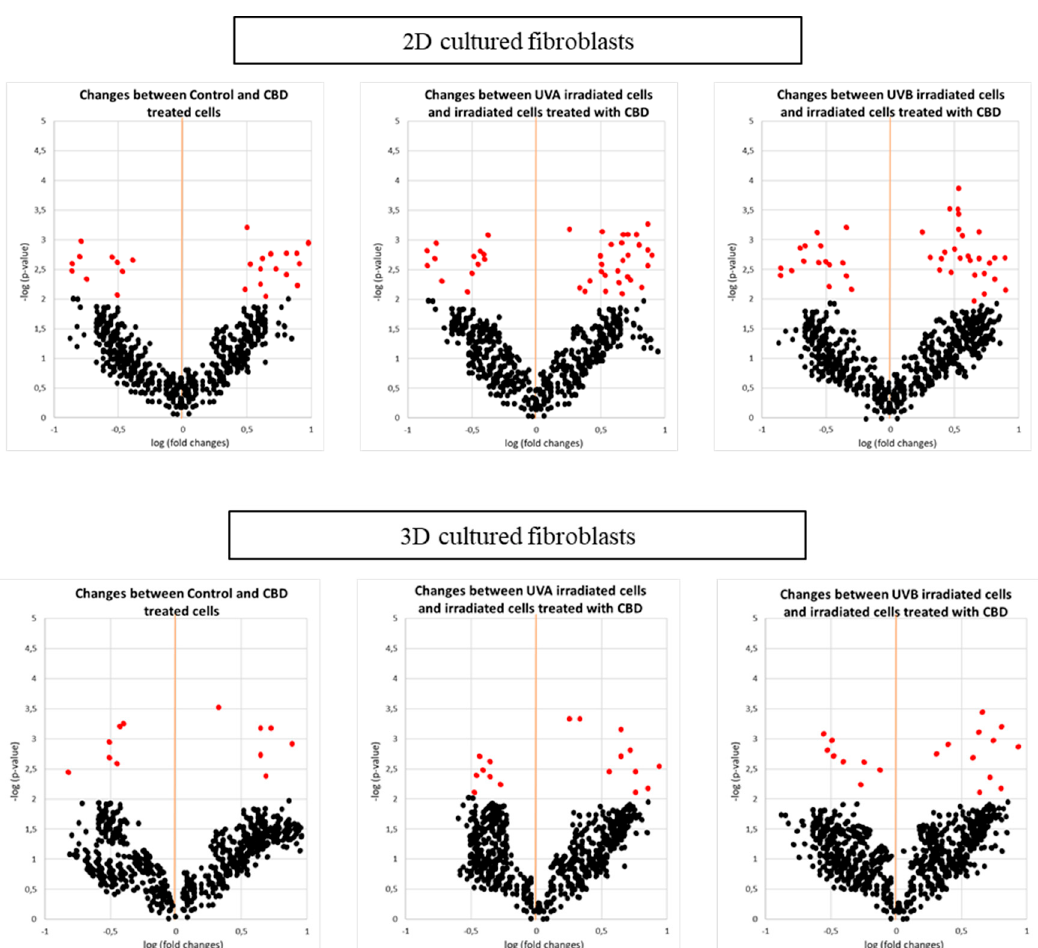
Figure 3. Volcano plots comparing the effect of cannabidiol (CBD, 4 μ M) on control fibroblasts and UVA (20 J/cm 2 ) or UVB (200 mJ/cm 2 ) irradiated cells in two-dimensional (2D) or three-dimensional (3D) culture model. Significant features (in red) had p < 0.05.